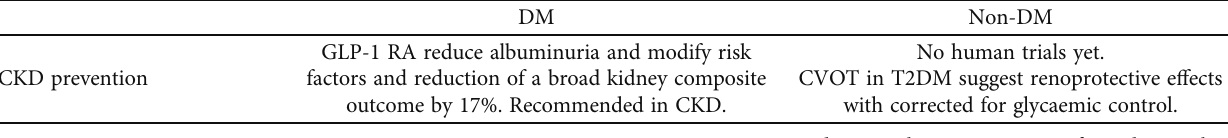
Table 2: Summary of GLP-1 RA preventive e ff ects in DM and non-DM